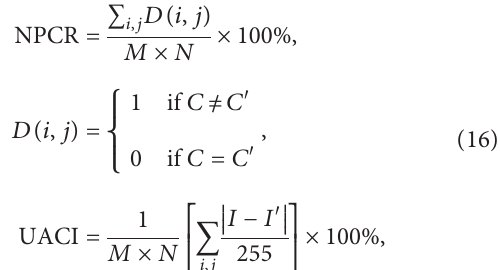
Figure 7: Noise attack and noised